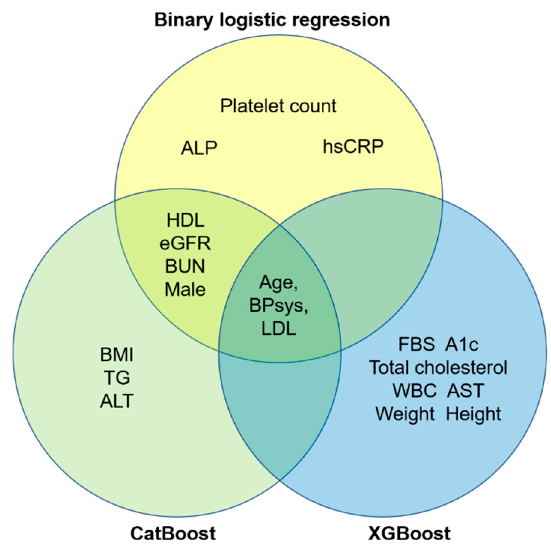
Figure 3. Variable importance plot in each machine algorithm. ALP, alkaline phosphatase; hsCRP, high sensitive C-reactive protein; HDL, high-density lipoprotein; eGFR, estimated glomerular filtration rate; BUN, blood urea nitrogen; BPsys, systolic blood pressure; LDL, low-density lipoprotein; BMI, body mass index; ALT, alanine aminotransferase; FBS, fasting blood sugar; WBC, white blood cell; AST, aspartate transaminase.